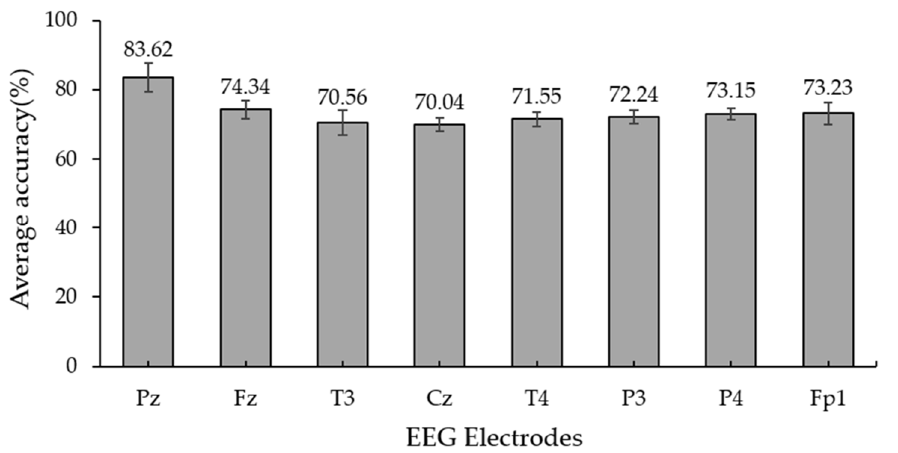
Figure 6. Average classification accuracy corresponding to different positions of electrodes of the proposed auditory ERP stimulation using SWLDA. Confidence interval (Alpha: 0.05).